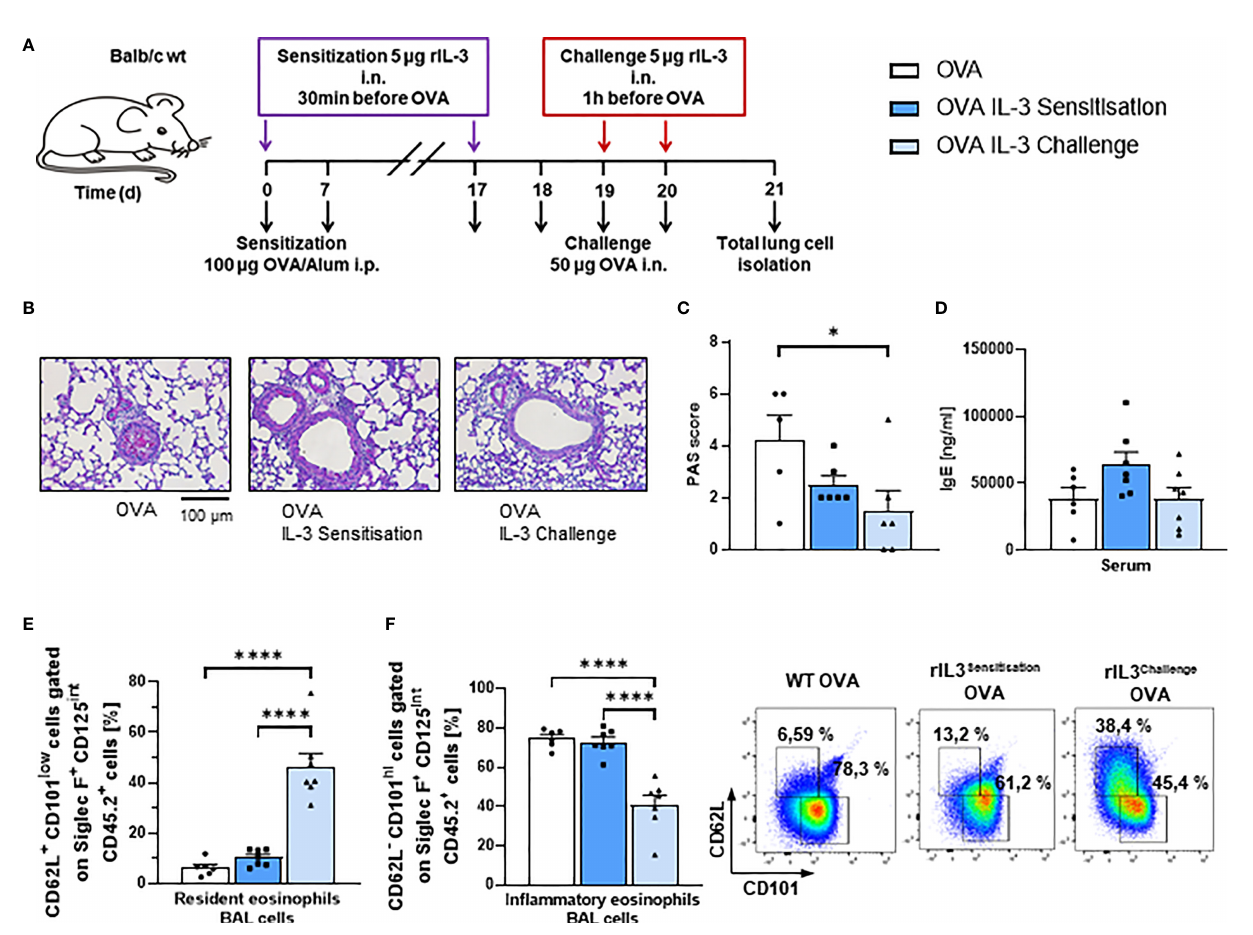
FIGURE 2 | Intranasal treatment with rIL-3 during the challenge phase inhibited airway eosinophil in fl ammation and mucus production in asthmatic mice. (A) Experimental design for the induction of allergic asthma in wild-type (WT) mice treated with rIL-3 during sensitization or challenge phase for the analysis of lung ILC2s. (B, C) Analysis of the mucus production in the airways. A representative light microscopic picture of the periodic acid-Schiff (PAS) staining of lung sections is shown for each group (n = 6/6/6). (D) Serum IgE level of WT mice with asthma and with and without additional rIL-3 treatment measured by ELISA (n = 6/7/7). (E, F) Flow cytometry analysis of resident (CD62L+CD101 low ) and in fl ammatory (CD62L − CD101 high ) eosinophils in the bronchoalveolar lavage (BAL) cells. A representative dot plot is shown for each group (n = 6/7/7). Data are presented as means ± SEMs. One-way ANOVA or Kruskal – Wallis test was used to calculate statistical signi fi cance. *p ≤ 0.05; ****p ≤